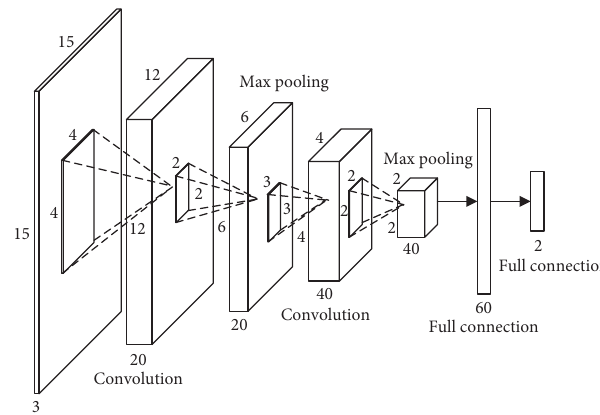
Figure 3: Network structure of level2-le21 CNN.